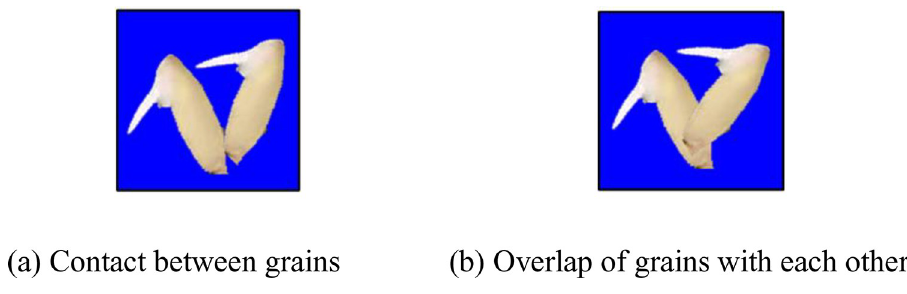
Fig 16. The grains touch or overlap each other.